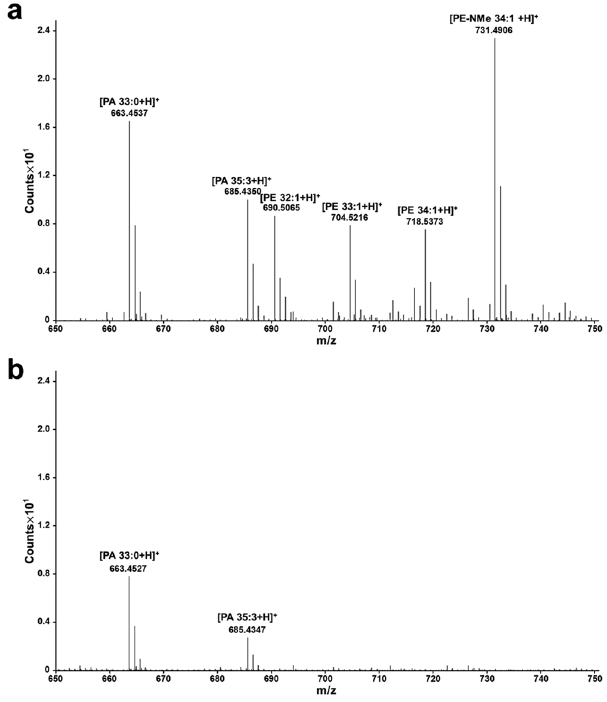
Figure 5. The results of LC-MS. LC-MS spectra of lipid extraction solutions from ( a ) mTnfaip8 and ( b ) the mTnfaip8 triple